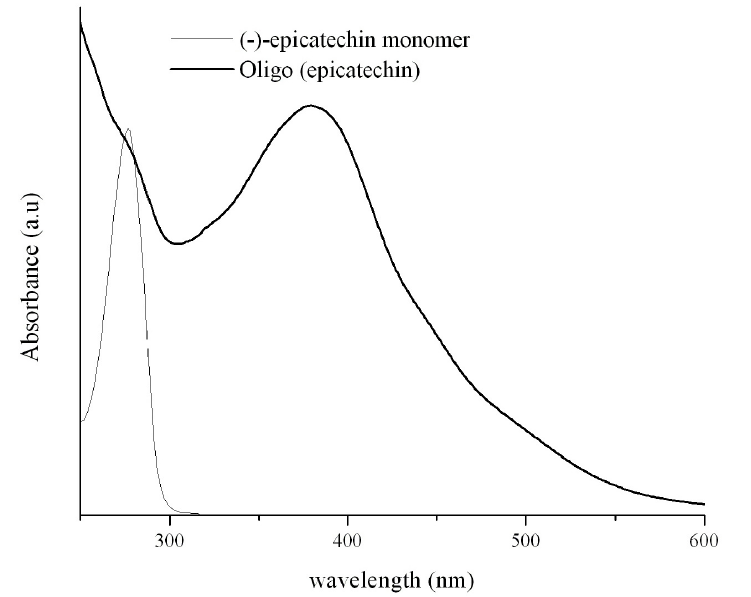
Figure 3. UV-Visible spectra for the oligomerization of